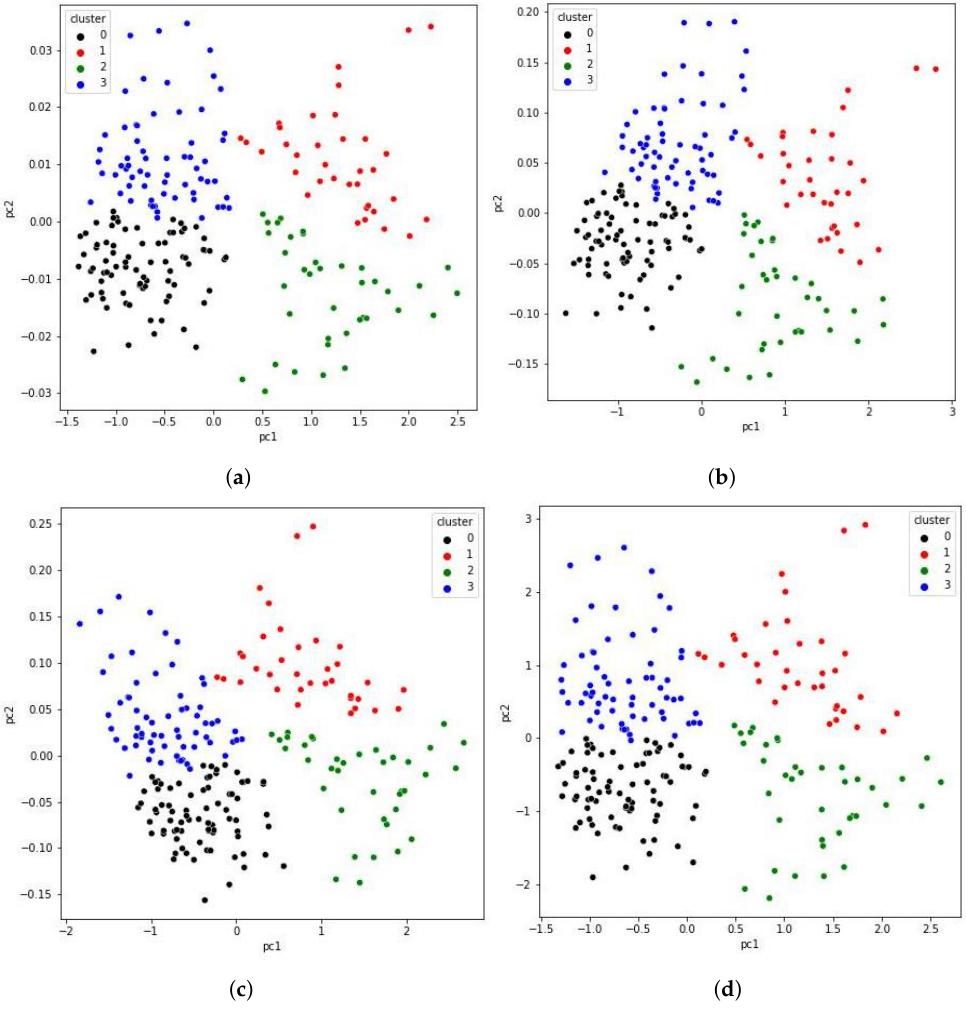
Figure 6. Bivariate risk index obtained with PLS for different response variables Y . ( a ) Y stages . ( b ) Y mosquitoes . ( c ) Y pupae . ( d ) Y all . Points in the scatterplots represent the